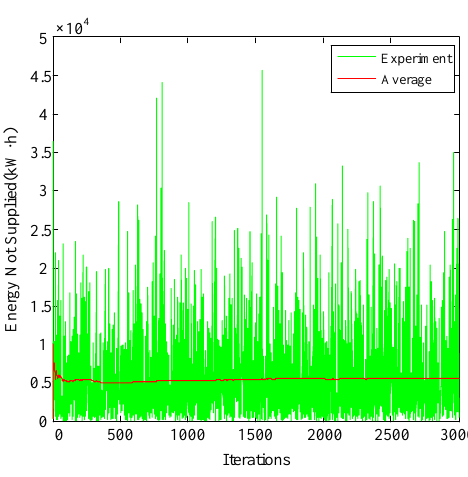
Figure 3. Expected energy not supplied for the aluminum alloy cable.